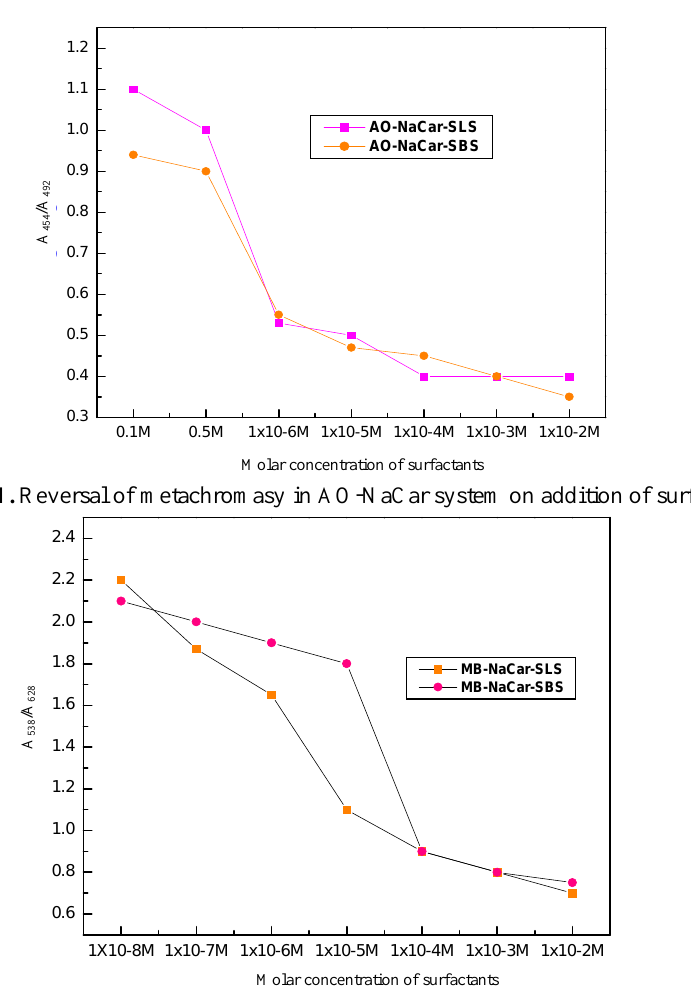
Figure 12. Reversal of metachromasy in MB-NaCar system on addition of surfactants Effect of